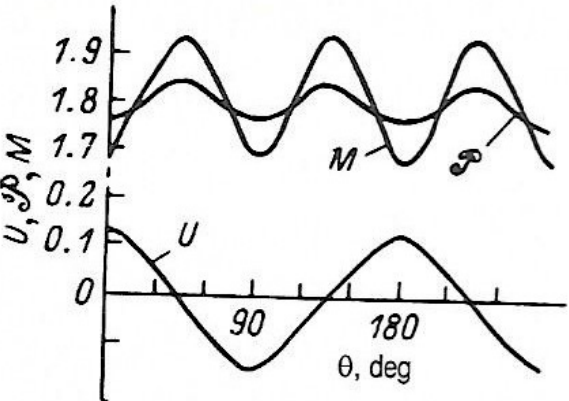
Figure 2. Dependence of the uniform polarization P, strain U , and magnetic moment M upon the angle between the external magnetic field and the crystal axis [100] in the antiferroelastic phase [20,21].